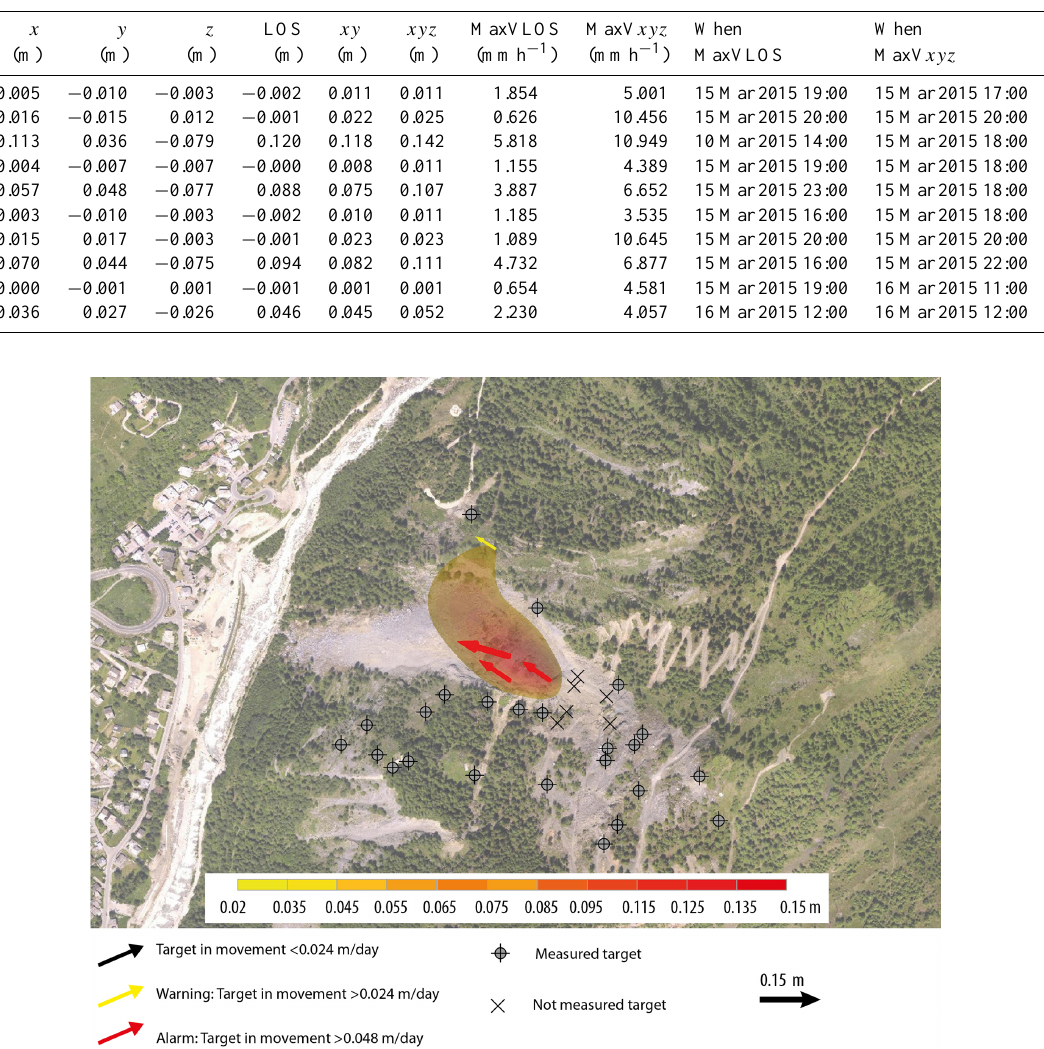
Table 2. Abstract of the numerical data published in near-real time on the website related to a 24h period between 15–16 March 2015. This table is delivered in particular for ROLE-3. The following is presented in the table: displacements over the three coordinates ( x , y , z ), line of sight displacement, planimetric and 3-D displacement resultants, amplitude and time when maximum velocities occurred in the reference period (both in line of sight and 3-D) and status with respect to the defined thresholds.